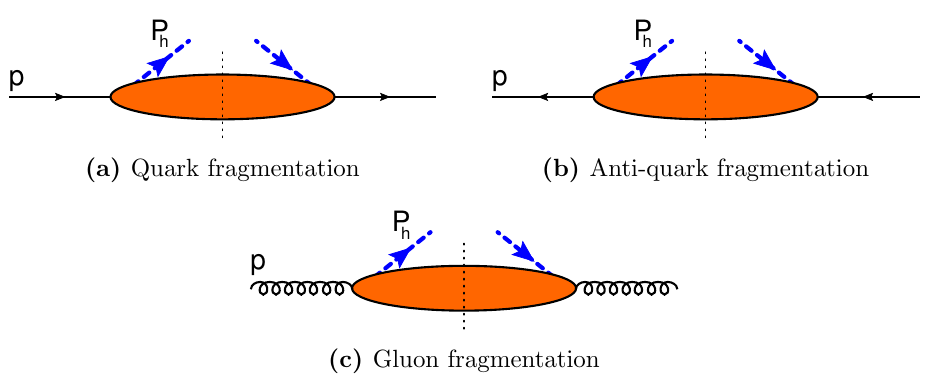
Figure 1. Diagrammatic representation of two-parton fragmentation